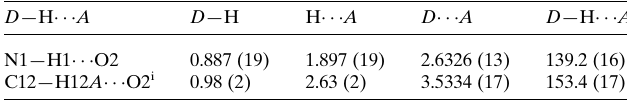
Table 1 Hydrogen-bond geometry (A˚ , (cid:3)